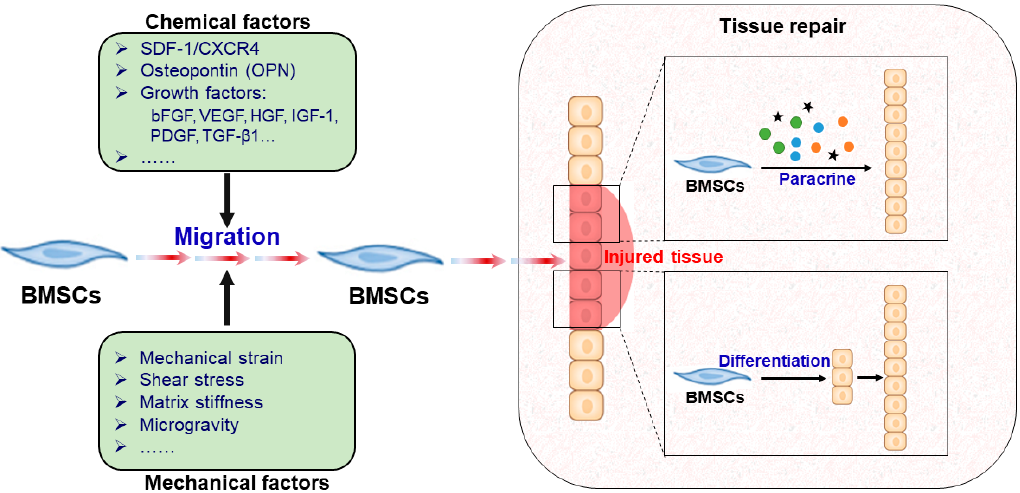
Figure 1. Proposed schematic diagram of the relationship between BMSC migration and tissue repair. Once BMSCs sense the injury signal released from damaged tissue, they migrate from bone marrow into the injured tissue through peripheral circulation, which is regulated by multiple mechanical and chemical factors. After reaching the damaged tissue site, BMSCs perform wound healing of damaged tissues through two key roles: the paracrine mechanism and/or directed differentiation.